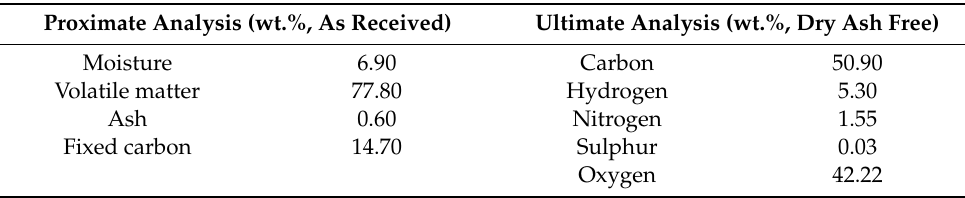
Figure 1. Samples of the fuels used in the experiments: ( a ) < 0.063 mm, ( b ) 0.125 up to 0.25 mm, and ( c ) > 1 mm. Table 1. Elemental analysis of pine wood pellets.